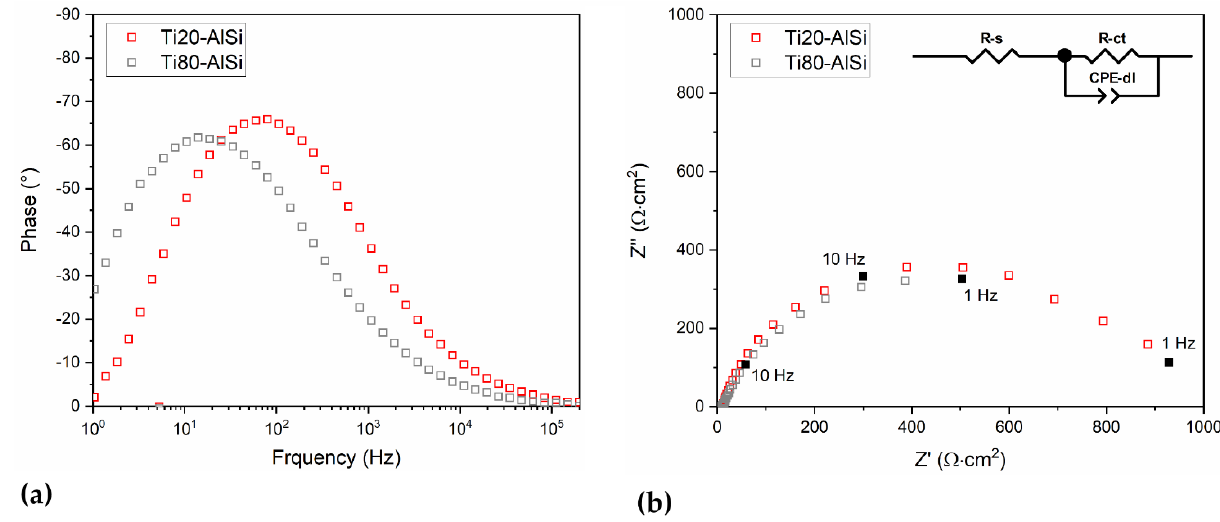
Figure 9. Electrochemical Impedance Spectroscopy was measured at OCP for the Ti20–AlSi (red squares) and Ti80–AlSi (grey squares) samples. ( a ) Bode plot of phase angle; ( b ) Nyquist plot, the inset shows the equivalent electric circuit used for fitting the measured data. Table 4. EIS fitting results with attributions: s= solution; ct = charge transfer; dl = double layer.